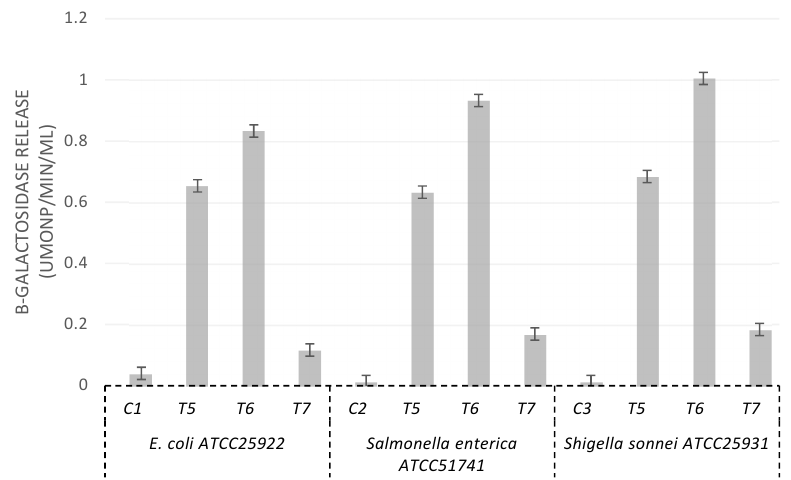
Figure 5. The membrane permeation of target E.coli ATCC25922, Salmonella enterica subsp. enterica ATCC51741, and Shigella sonnei ATCC25931. Bacteria (after 120 min incubation) were removed by centrifugation and enzyme release was assayed in the cell-free supernatant. Legend: C1, C2, C3: untreated cells; T5: (Cys5-4+ Gt28) PP: 1:3 ( v/v ); T6: (Cys5-4+ Gt28) PP: 3:1 ( v/v ); T7: nisin (Sigma-Aldrich, USA). Results are representative of three independent experiments each made in triplicate. The release of o-nitrophenol (ONP) per minute per mL and calculated as described: [A415 × 1000/sample volume ( μ L)]/reaction time (min) x 4.86; where A415 was the absorbance at 415 nm and 4.86 was the coefficient of extinction (mM − 1 cm − 1 ) of ONP, respectively.